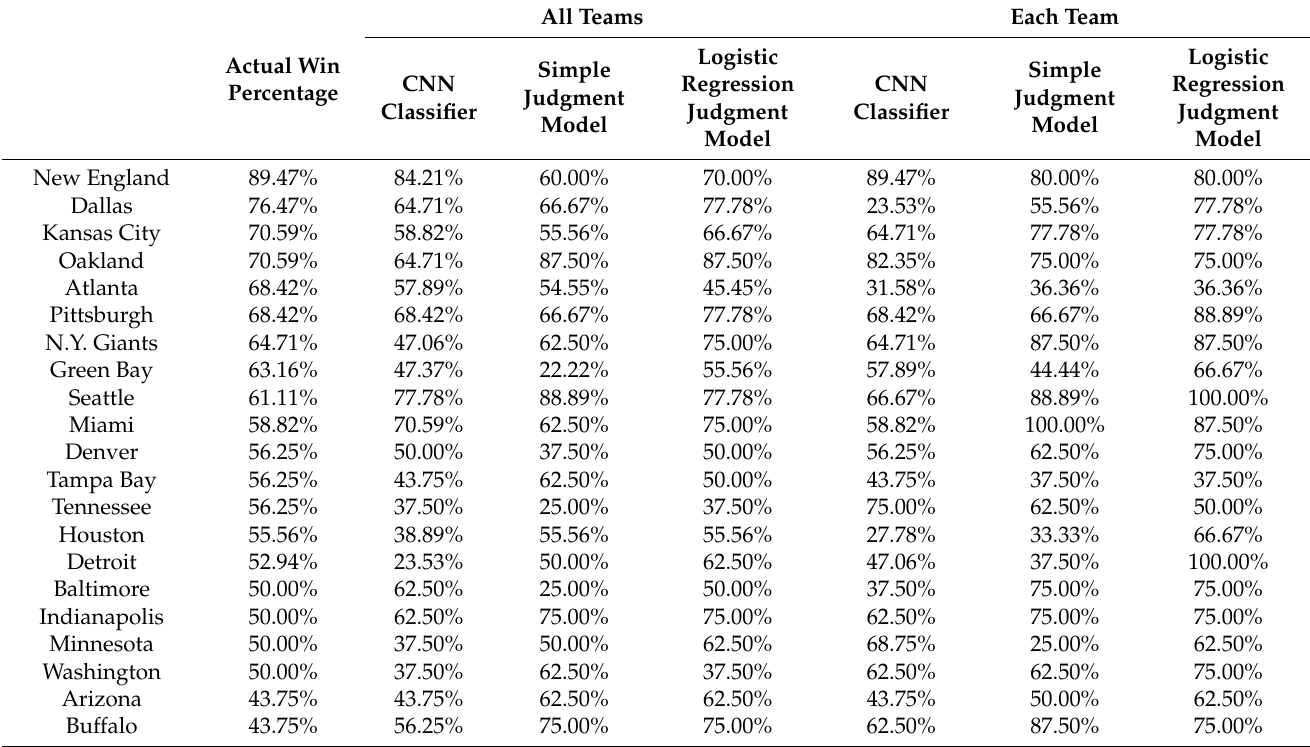
Table 1. Comparison of the accuracy of modeling with all teams’ data and each team’s